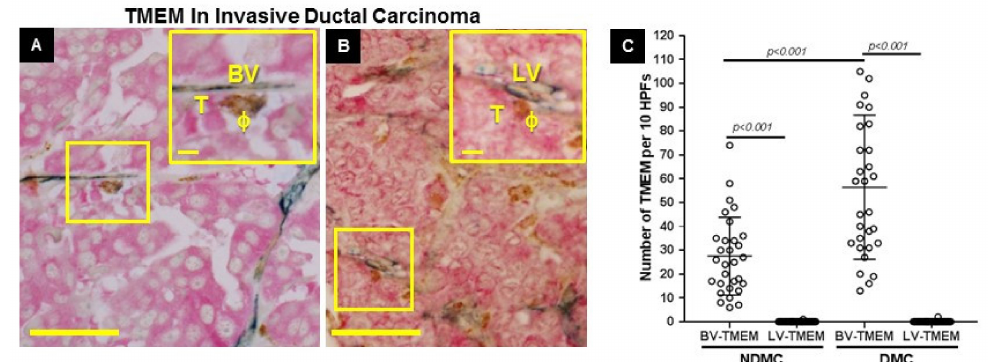
Figure 2. Blood vessel-tumor microenvironment of metastasis (BV-TMEM) are common in primary breast tumors and lymphatic vessel (LV-TMEM) are very rare. ( A ) BV-TMEM is a tripartite structure composed of a BV (blue, CD31), a perivascular macrophage ( φ , brown, CD68), and a Mena-overexpressing tumor cell (T, pink, pan-Mena), all in direct contact. ( B ) LV-TMEM is a tripartite structure composed of an LV (blue, D2-40), a perivascular macrophage ( φ , brown, CD68), and a Mena-overexpressing tumor cell (T, pink, pan-Mena), all in direct contact. Examples of TMEM locations are specified in yellow boxes at both low and high magnification (insets). Scale bars = 80 µ m. Inset scale bars = 10 µ m. ( C ) Quantification of BV-TMEM and LV-TMEM in the non-distant metastatic (NDMC) and distant metastatic human (DMC) patient cohorts (in all comparisons p < 0.001). See Table 3 for raw